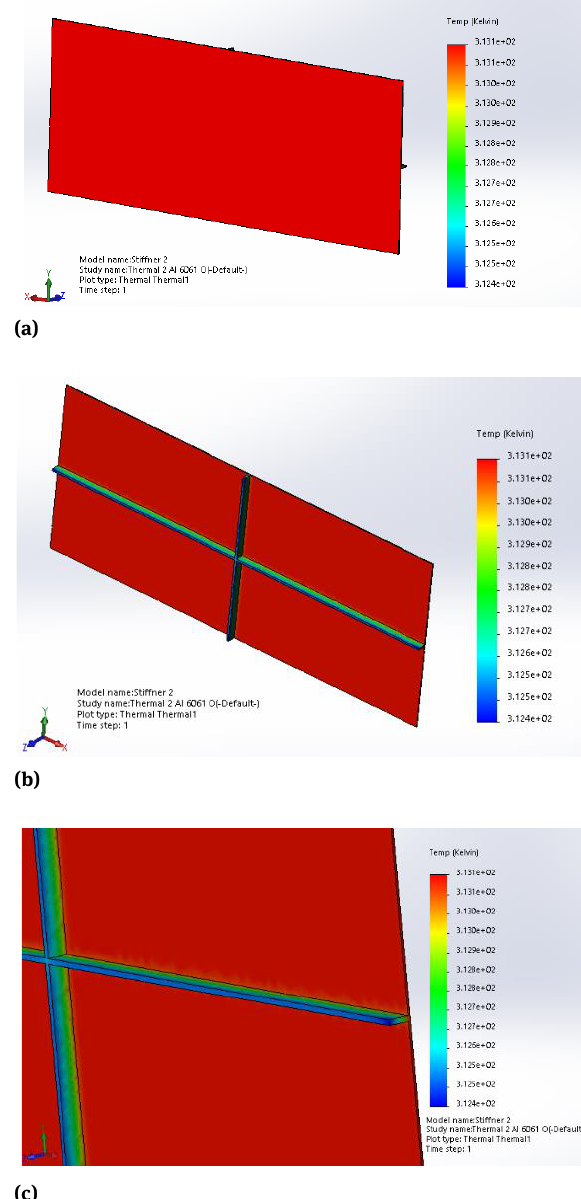
Figure 25: Result of the thermal simulation for the flat wall with a cross stiffener: (a) outer surface, (b) inner surface, (c)